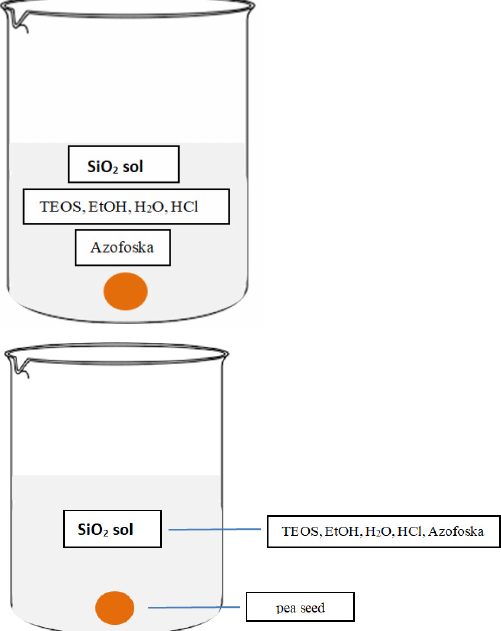
Figure 1. Deposition of the SiO 2 -Azofoska coating on pea seeds.